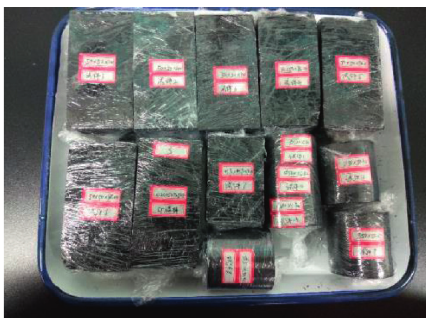
Figure 1: The photograph of coal samples.